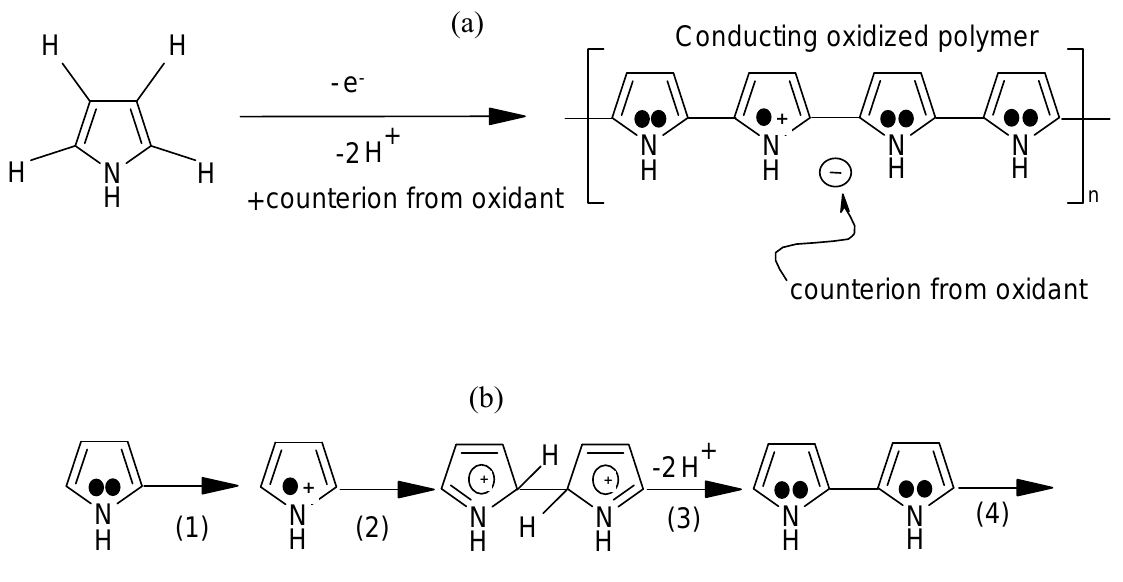
Figure 9. Mechanism illustrating the formation of polypyrrole (a) Overall process